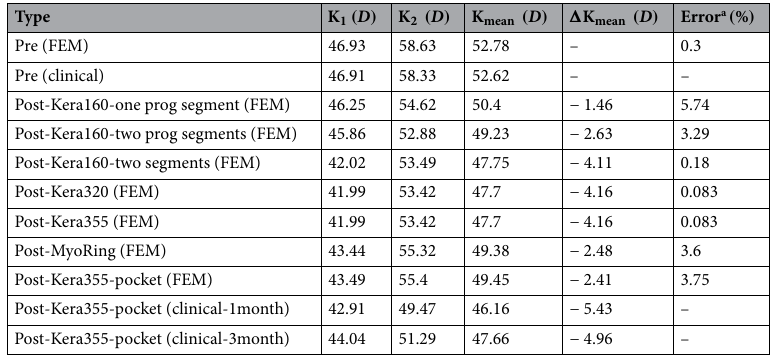
Table 1. Pre- and postoperative keratometry results of the first case. a Percentage error of FEM predictaed K mean .